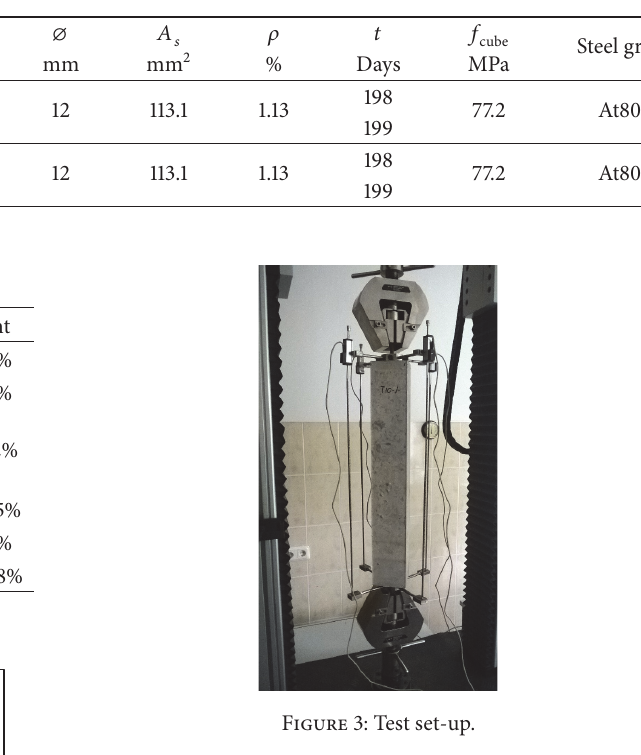
Table 1: Main characteristics of the test ties.